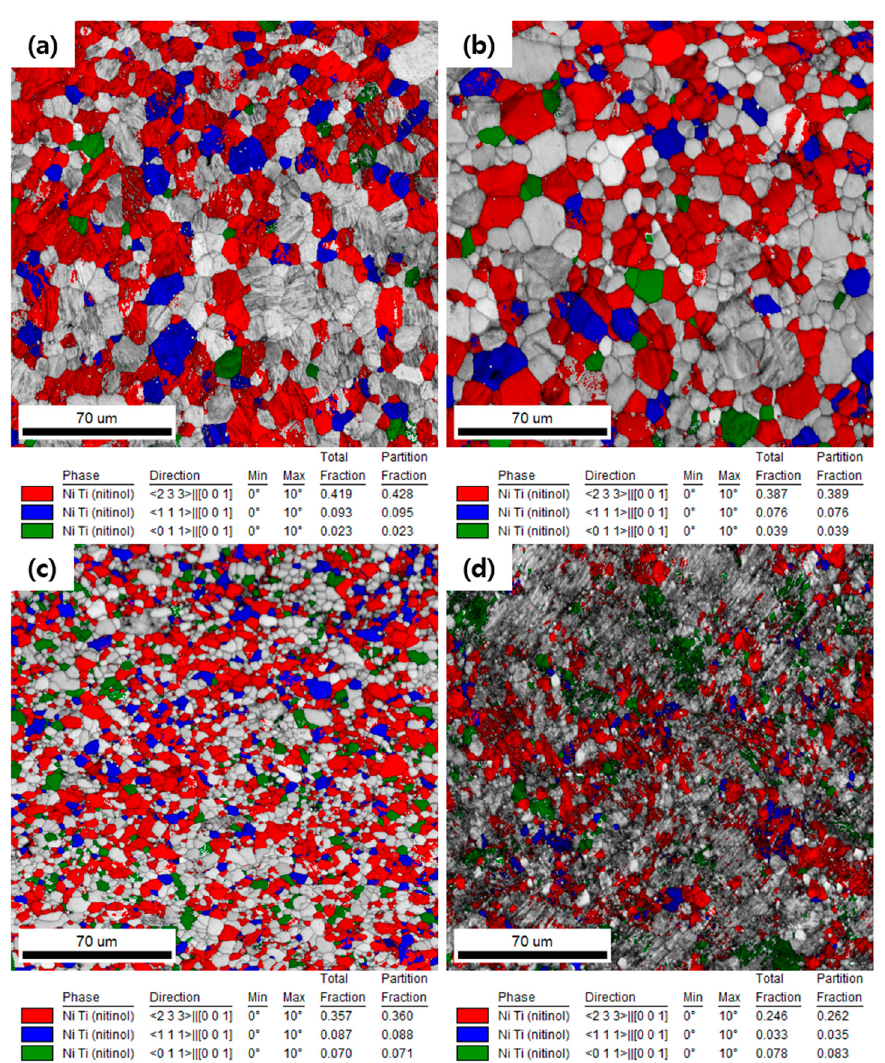
Figure 10. The [233] B2 //RD, [111] B2 //RD and [011] B2 //RD texture components mapped on the EBSD-generated microstructures of the AR samples ( a ) annealed for 5 min at 873 K and ( b ) annealed for 5 min at 873 K and then aged at 523 K for 16 h, and the HRDSR samples ( c ) annealed for 5 min at 873 K and ( d ) annealed for 5 min at 873 K and then aged at 523 K for 16 h.